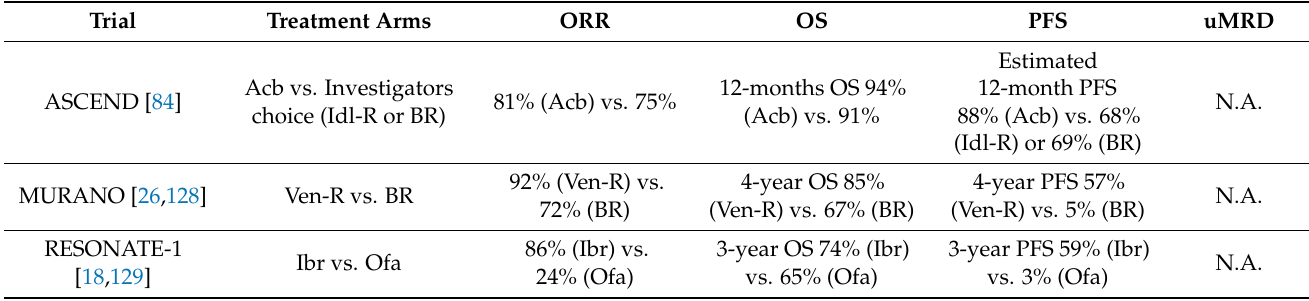
Table 2. Overview of phase 3 trials in